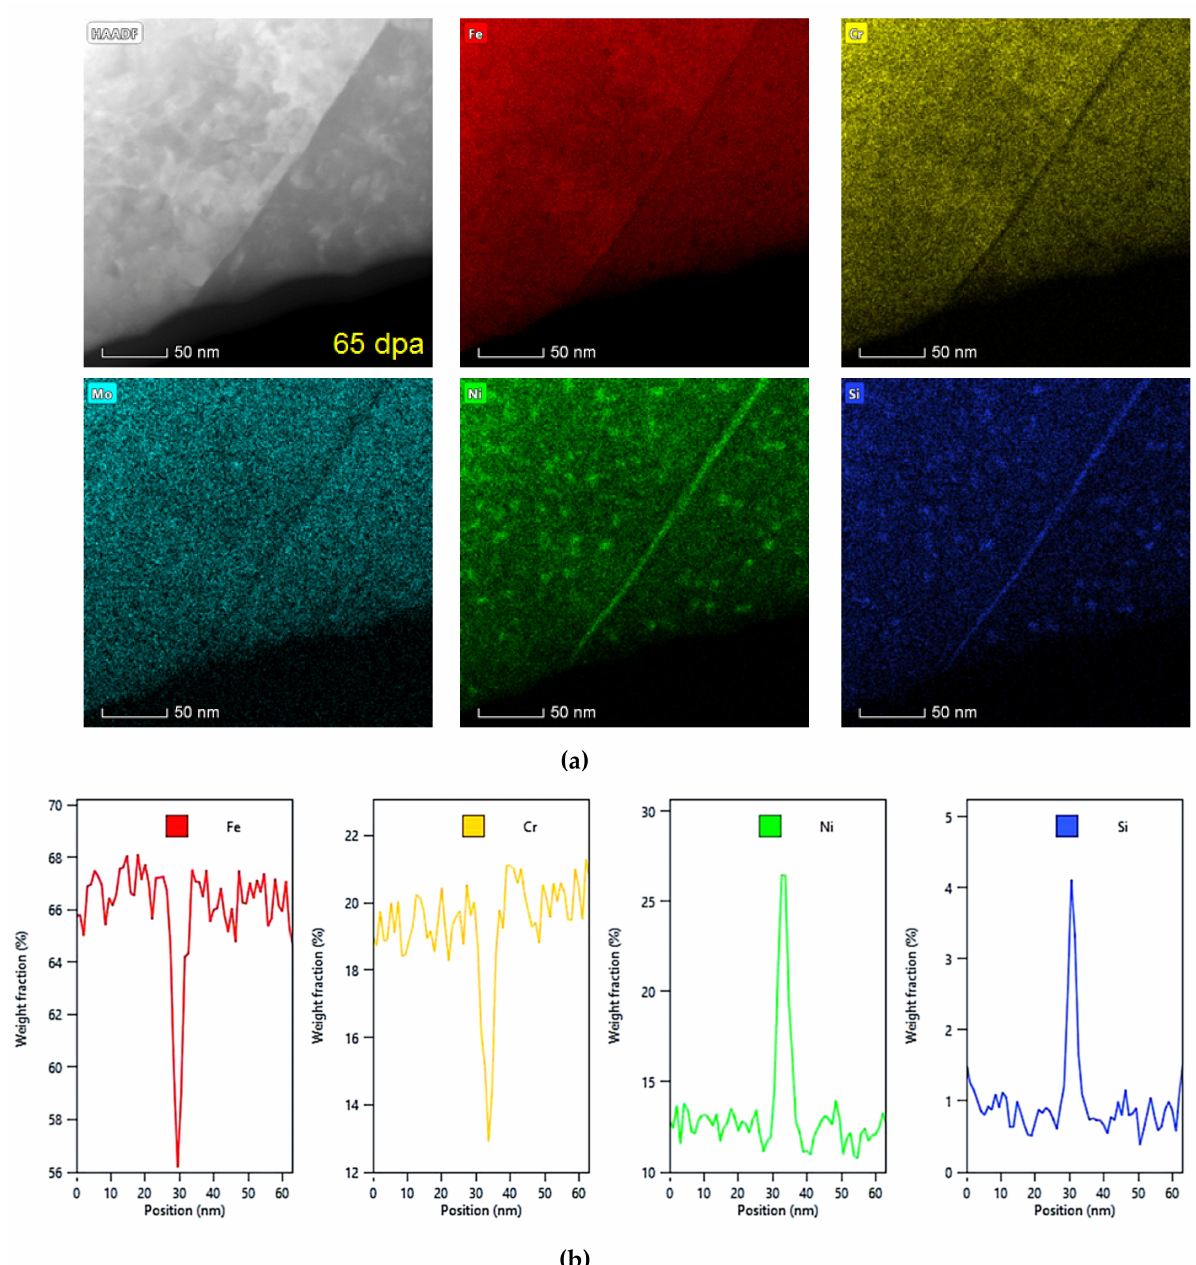
Figure 16. ( a ) Spectral images of a grain boundary in the as-irradiated 65 dpa FTT material, clockwise from upper left: HAADF image and element maps for Fe, Cr, Si, Ni and Mo. The element maps show Ni and Si co-segregation accompanied by Cr and Fe depletion at the GB. Mo also appears to be depleted at the GB. ( b ) Profiles across the grain boundary extracted from the spectral images for (from left to right) Fe, Cr, Ni and Si, showing the extent of depletion and enrichment. The apparent quantities in spectral images is dependent upon the total number of elements included in the quantification, so should not be taken as absolute values, but relative changes in each